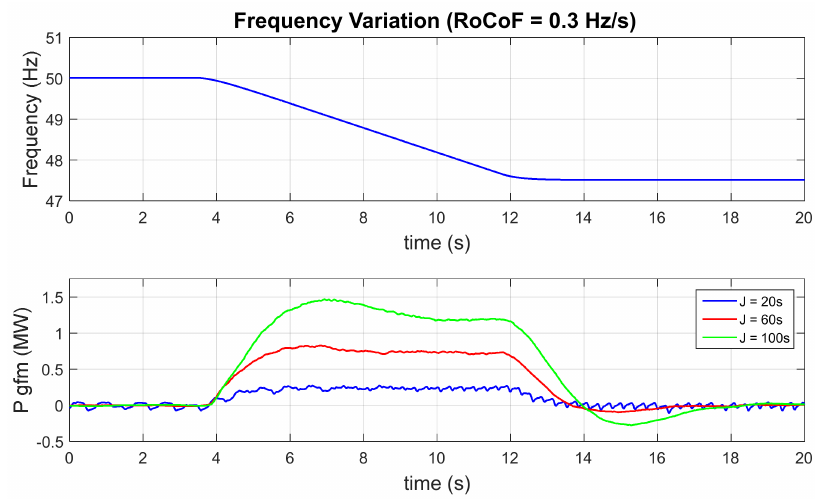
Figure 12. Active power provided by the VSC at a frequency variation for different J values.